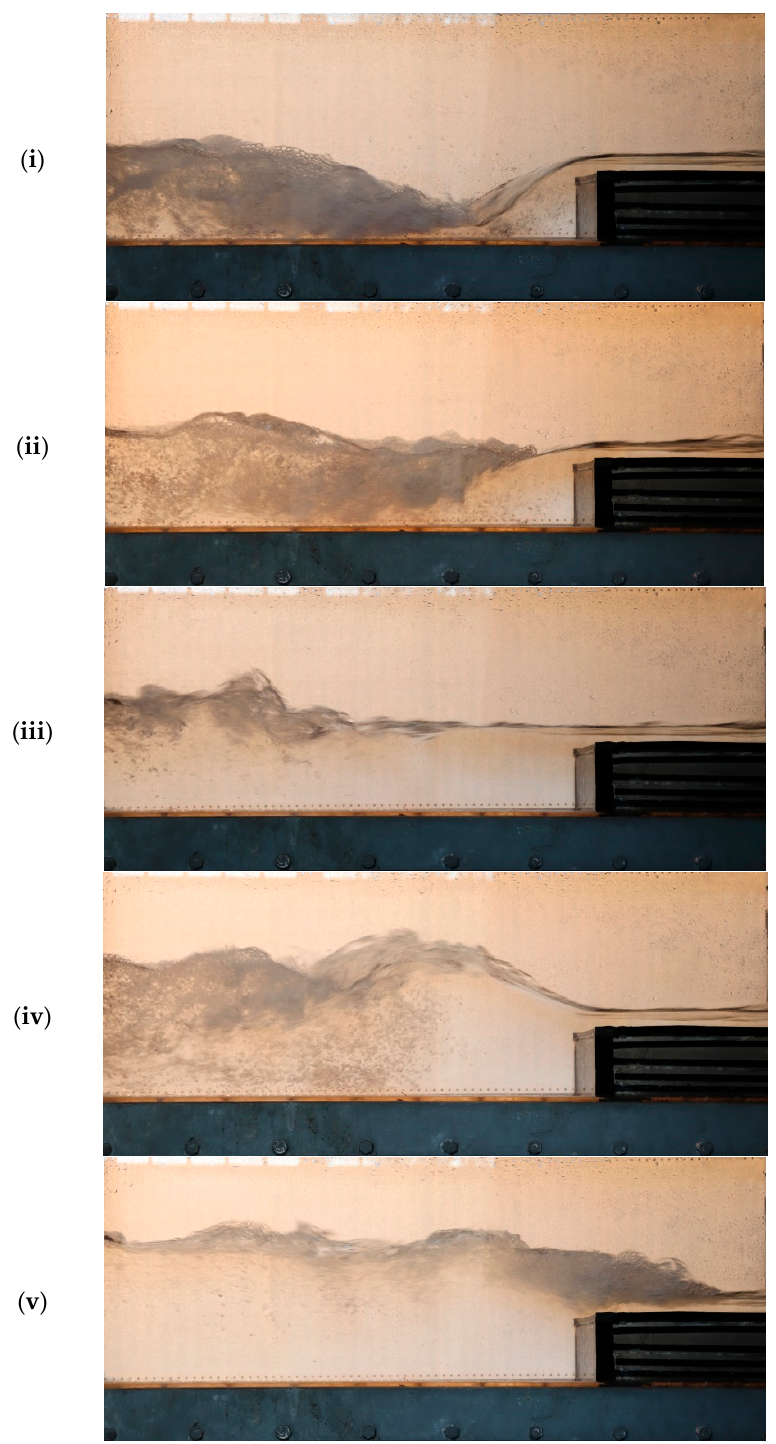
Figure 1. Transition from supercritical to subcritical flow around a vertical step, ( i ) minimum B-jump, ( ii ) B-jump, ( iii ) wave-train, ( iv ) wave-jump and ( v ) A-jump.